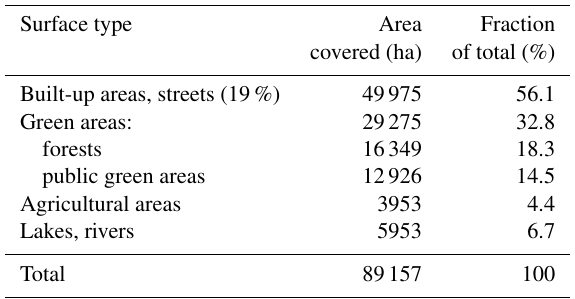
Table 2. Contribution of different surface types to the total surface area of